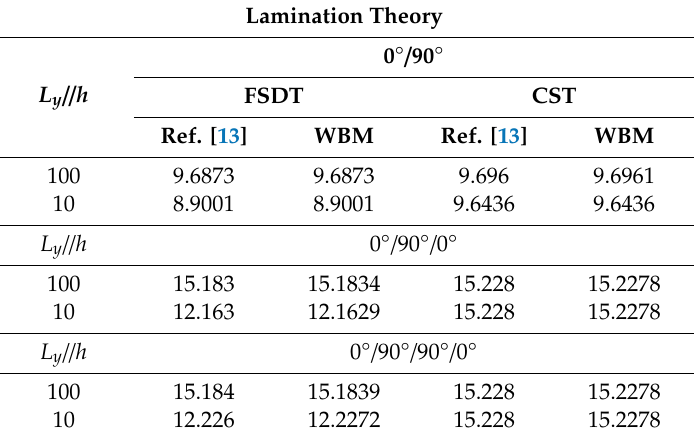
Table 4. The fundamental frequency parameter Ω for a composite plate with the SD-SD boundary condition by variety